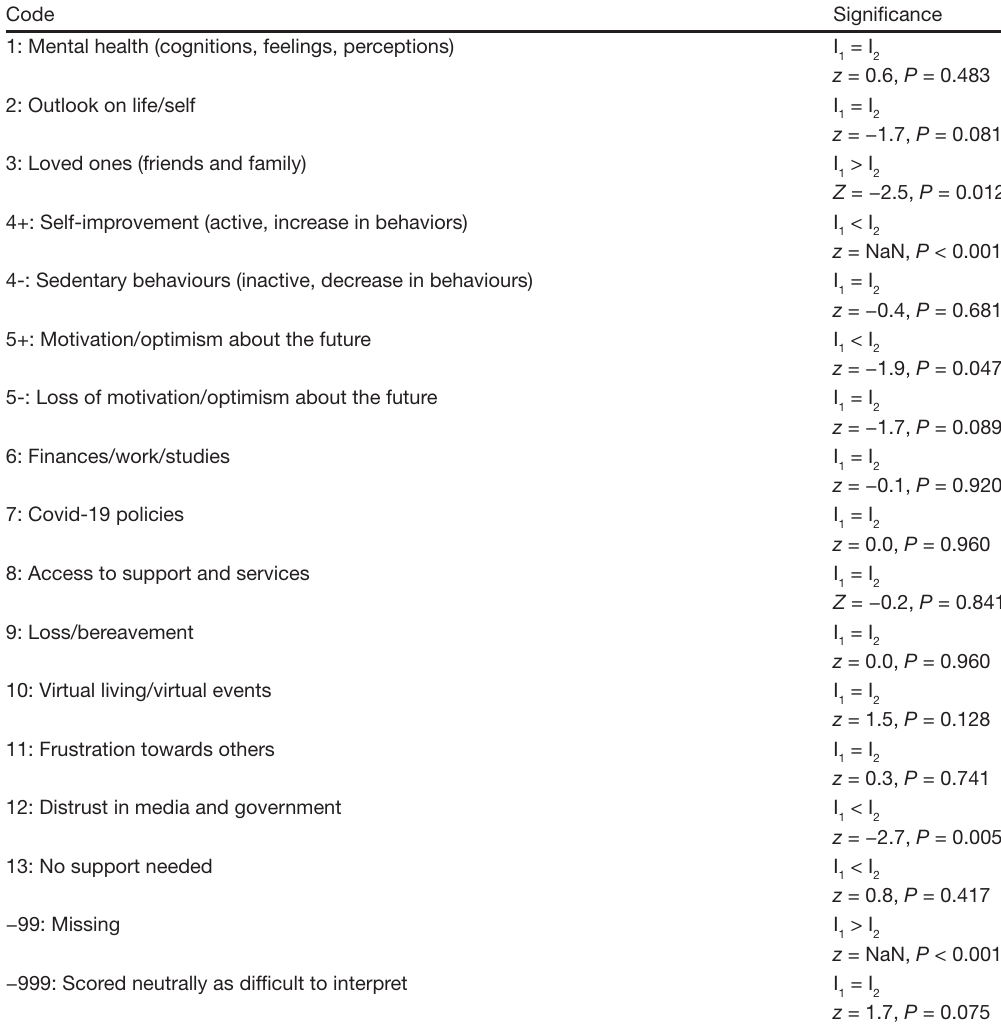
Table 7. Analysis of code frequencies between participants with a higher income of £40,000 per year (I ) and participants with a lower income of £40,000 per year (I 1